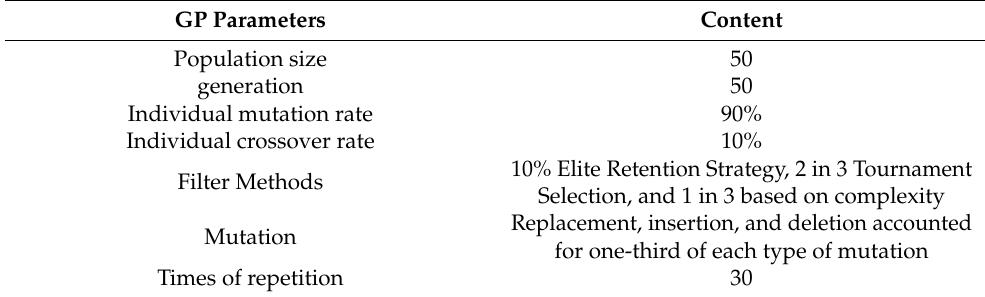
Table 2. Genetic Programming parameters